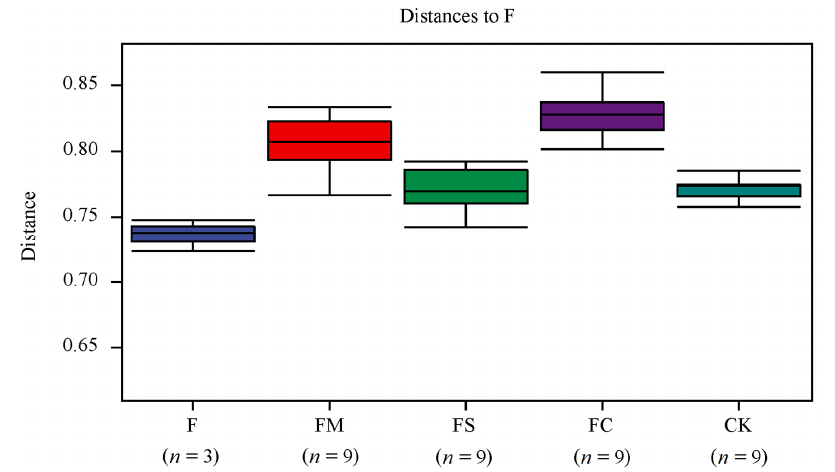
Figure 5. PERMANOVA between groups. Note: F: chemical fertilizer; FM: chemical fertilizer + cattle manure; FS: chemical fertilizer + maize straw; FC: chemical fertilizer + pig manure; CK: control without fertilizers.